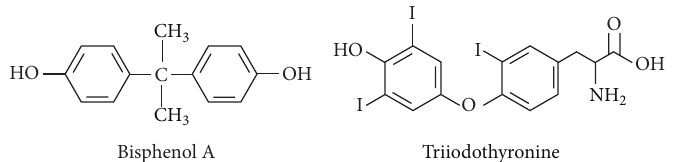
Figure 11: This diagram illustrates the structural similarity between bisphenol A and triiodothyronine, leading to potential cross-reactivity.